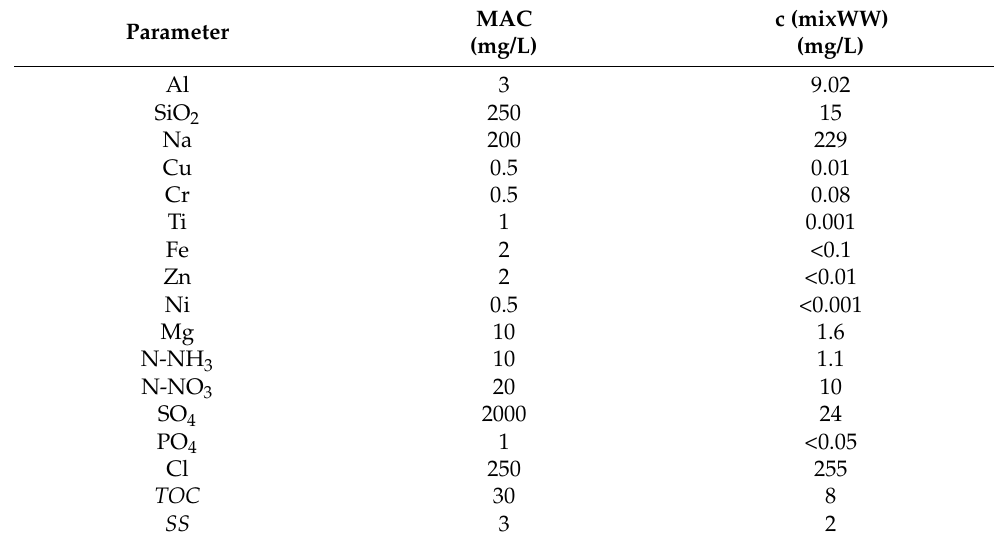
Table 4. Measured chemical parameters in the wastewater mixture